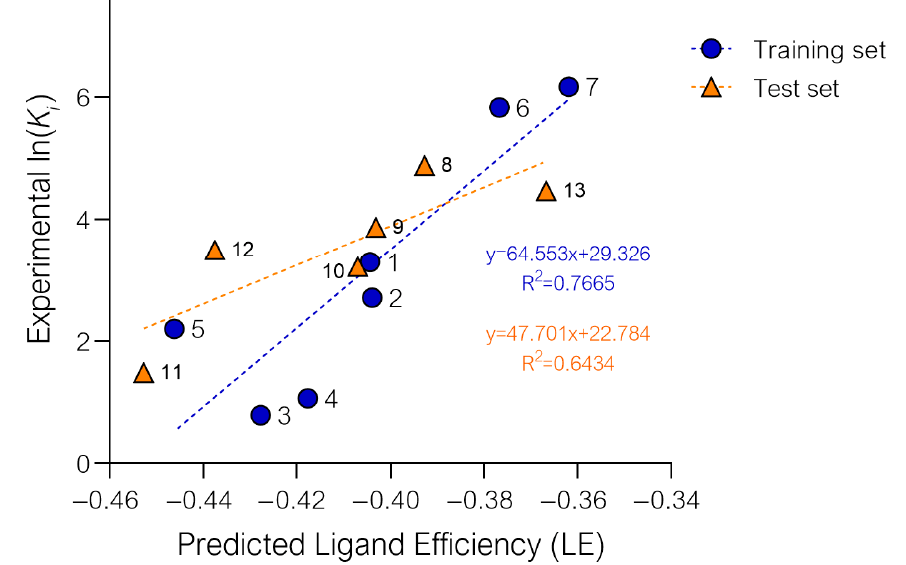
Figure 8. Correlation between calculated LE and experimental ln( K i ). Blue color indicates the line, the equation and the R 2 value for the correlation between LE and ln( K i ) for the first data set compounds 1 – 7 employed for the model construction. With orange color are indicated the line, the equation and the R 2 value for the correlation between LE and ln( K i ) for the wider data set, including all compounds 1 – 13 .